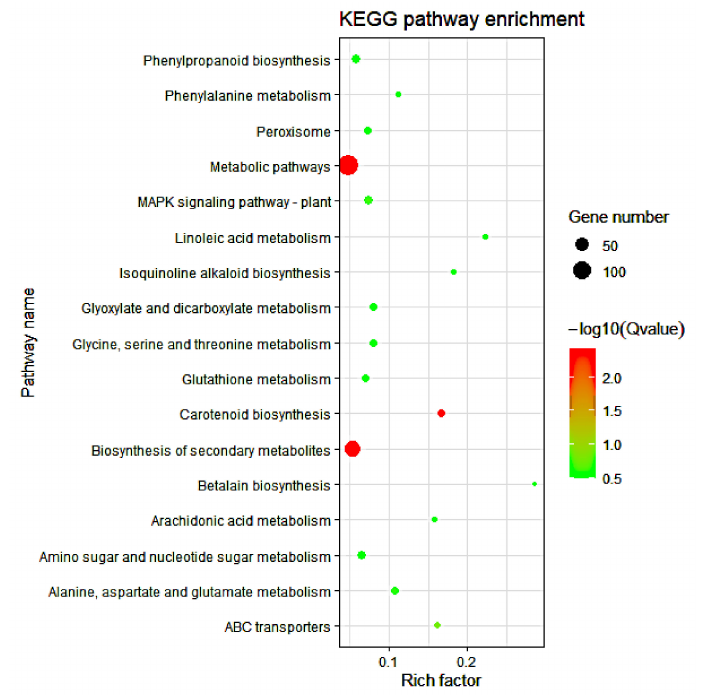
Figure 7. KEGG pathway enrichment analysis of the 1656 common cold-responsive genes. The experimental comparisons were based on the hypergeometric test, while the significance of the enrichment of the KEGG pathway was based on q value, q < 0.05. The color gradient represents the size of the q value; the color ranges from green to red, and the closer to green, the smaller the q value and the higher the significant degree of enrichment of the corresponding KEGG pathway. The “rich factor” represents the percentage of DEGs to total genes in a given